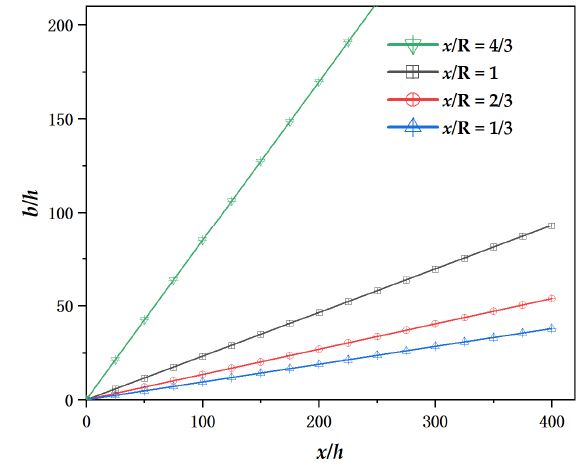
Figure 4. Jet growth with downstream distance.